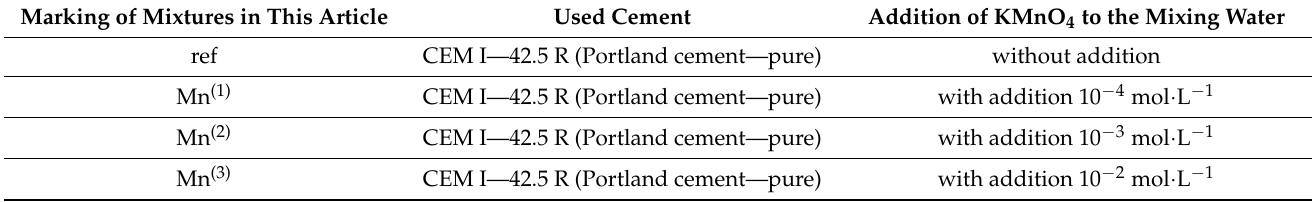
Table 4. Detailed characterization of the amount of KMnO 4 addition to the mixtures of all concrete